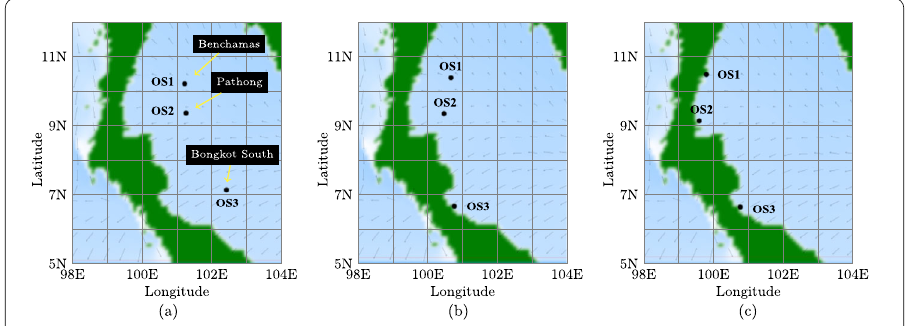
Figure 1 The movement of oil slicks. The simulation of the movement of three oil slicks, denoted by OS1, OS2, and OS3, originating from the different drilling rigs on 6 December 2018, a day with the fine weather. Three snapshots are illustrated: ( a ) when the oil slicks occur at the rigs, ( b ) when they drift to the sea surface, and ( c ) when they land on the coastal